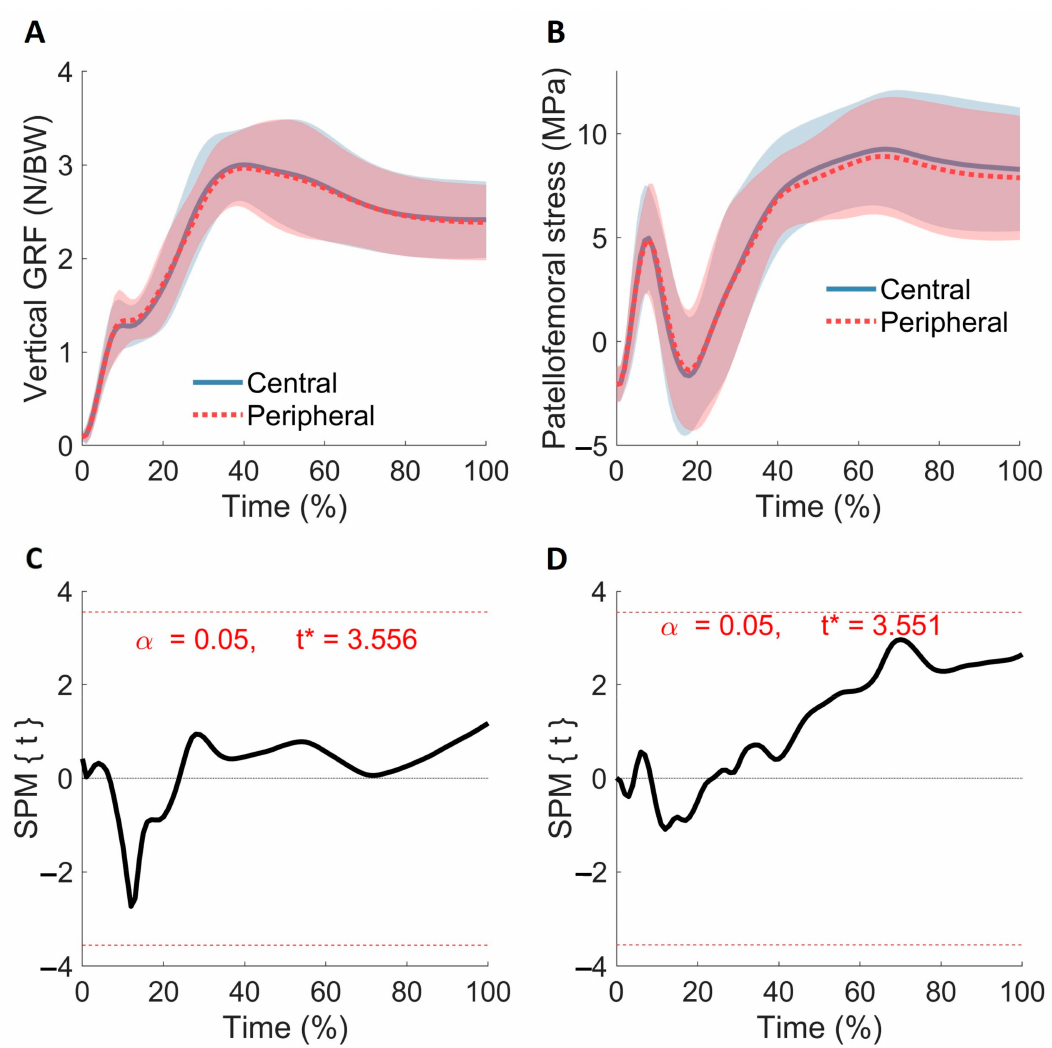
Figure 5. Vertical ground reaction force and patellofemoral joint stress (PFJS). Descriptive statistics for each condition (mean ± 1 standard deviation error cloud) for vertical ground reaction force ( A ) and PFJS ( B ). Time was determined from initial contact (0%) to peak knee flexion (100%). The black line is the t-value of each time point for the vertical ground reaction force ( C ) and PFJS ( D ). The dotted redline is the threshold of significance. Likewise, no significant difference was observed in vertical ground reaction force and PFJS between the landing